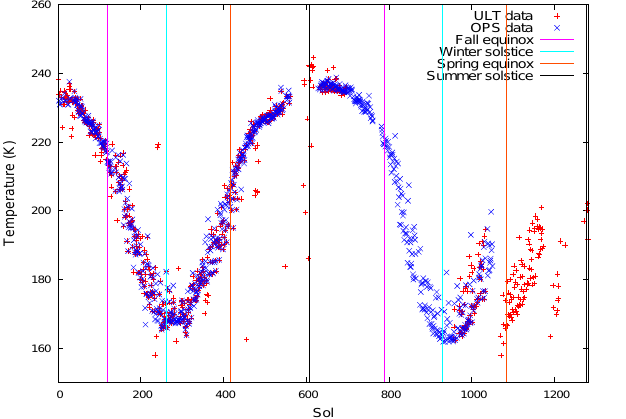
Fig. 6. ULT temperature data of VL1 sol 645.